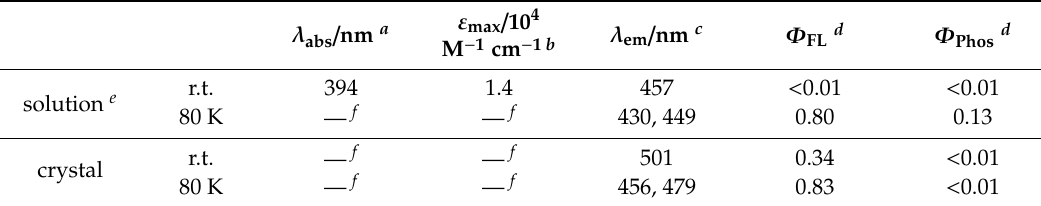
Table 3. Photoluminescence lifetimes and kinetic constants of LAlH .